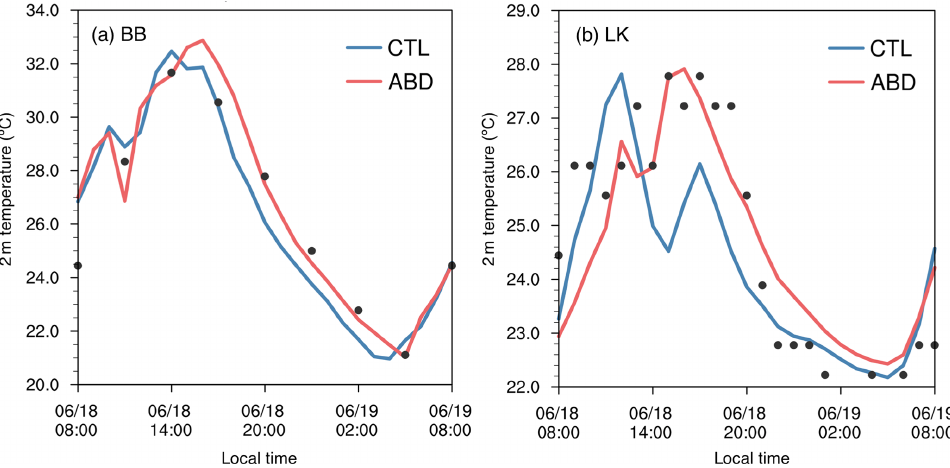
Figure 8. Simulated and observed 2m temperature at meteorological stations (a) BB (Bengbu) and (b) LK (Lukou) on 18 June 2012. Note that locations of BB (Bengbu) and LK (Lukou) are marked in Fig.